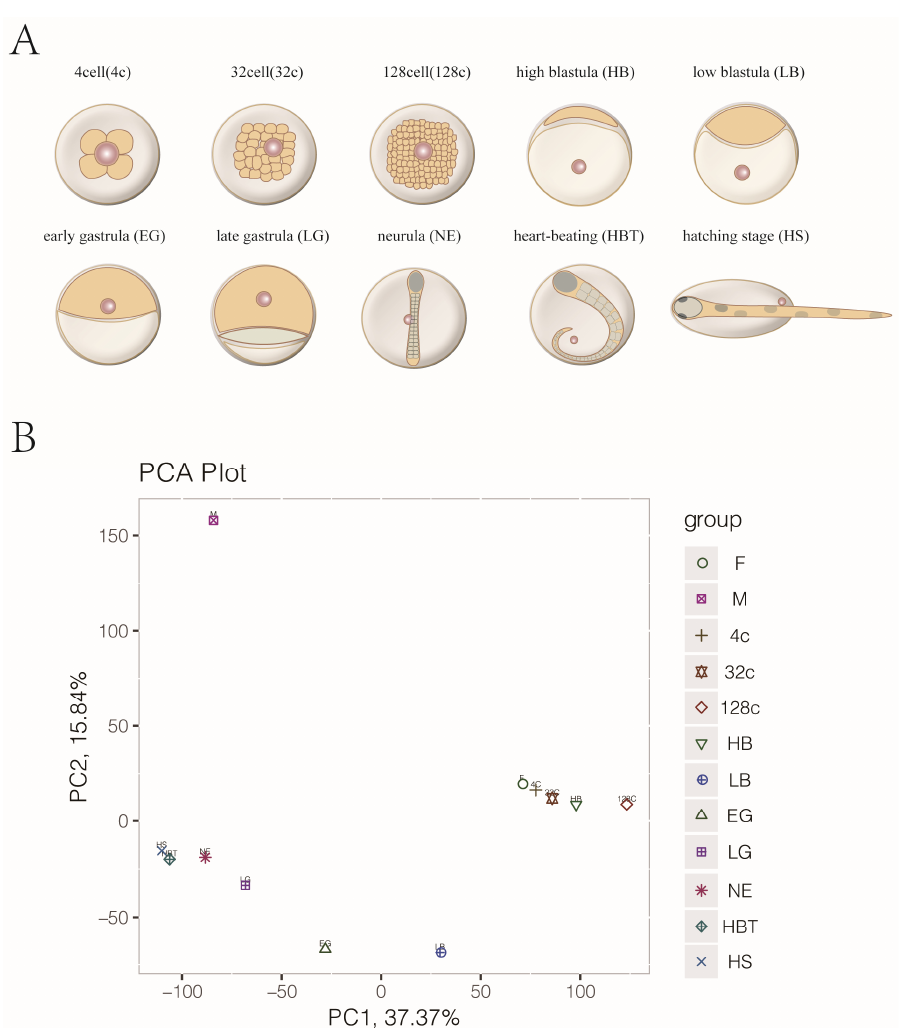
Figure 1. The samples collection and clustering analysis during embryonic development. ( A ): A scheme of Japanese flounder embryonic developmental stages. ( B ): Principal component analysis (PCA) showed a clear cluster during gametes and embryo development. M: sperm, F: egg, 4c: 4-cell, 32c: 32-cell, 128c: 128-cell, HB: high blastula, LB: low blastula, EG: early gastrula, LG: late gastrula, NE: neurula, HBT: heart-beating, HS: hatching stage.